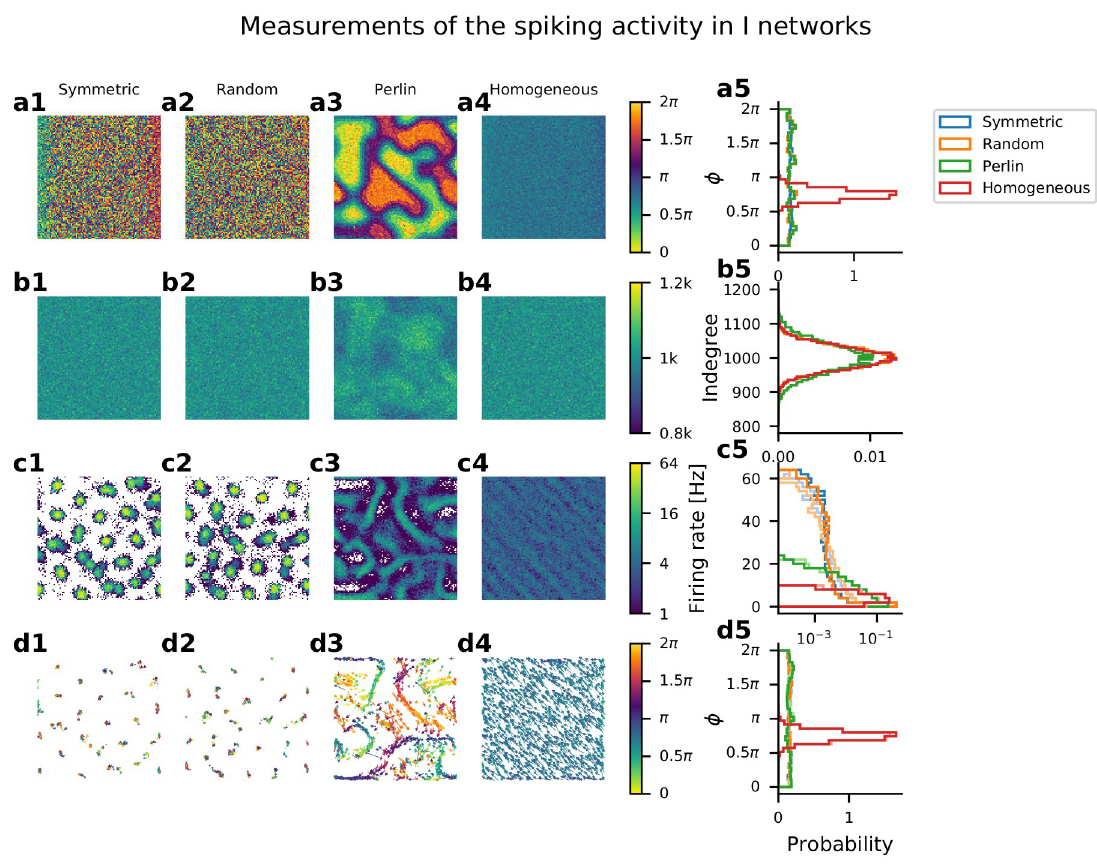
Fig 2. Network structure and spiking activity in I-networks. (a) Spatial distribution of connection asymmetries. The square represents the 2-D space of the network. The four panels ( a1-a4 ) show the four different configurations of asymmetric connectivity: symmetric, random, Perlin and homogeneous. The panel a5 shows the distribution of ϕ , measured for each neuron from the locations of its post- synaptic neurons. (b) Spatial distribution of in-degrees of individual neurons in the four configurations ( b1-b4 ). The in-degree distribution was similar for all four configurations ( b5 ). Note that in the Perlin configuration, neurons with high and low in-degree were spatially clustered ( b3 ). (c) Spatial distribution of average firing rates of individual neurons in the four network configurations ( c1-c4 ). ( c5 )The distribution of firing rate of all the neurons. (d1-d4) Spatially distributed direction of neuronal activity flow in the four configurations. (d5) Distribution of the direction of neuronal activity flow independent of space. In symmetric, random and Perlin configurations, activity could move in all possible directions (blue, orange, green), whereas in the homogeneous configuration, activity flowed in a single direction (red). Note that in symmetric and random configurations, despite the presence of all possible directions of projection, the network activity remained locked at certain specific locations ( d1,d2 ), unlike in the Perlin configuration, in which a clear and spatially diverse flow of activity emerged ( d3 ).